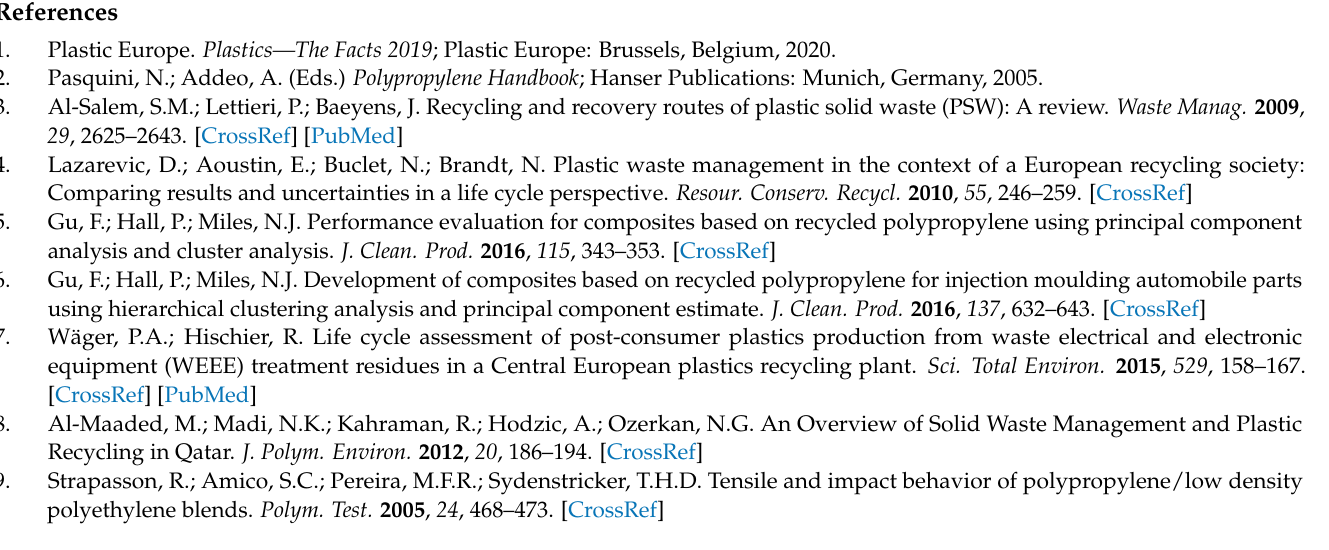
Figure A1. SEM images of the virgin material of PP4 and the recycled flakes of cups and bucket ( A ) and the blend series on basis of PP2 ( B ), LCB-PP with PODIC C126 ( C ), LCB-PP with PEROXAN LP ( D ), HMS-PP ( E